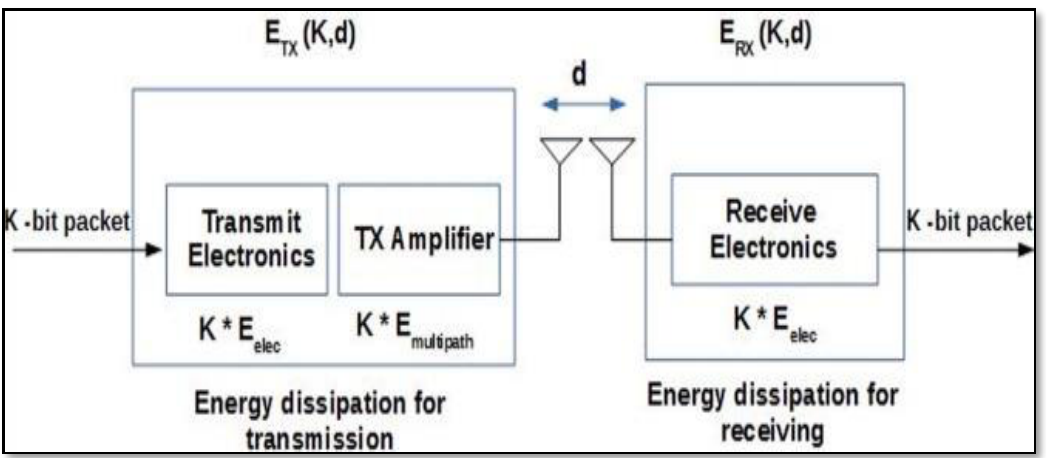
Figure 2. Energy model.